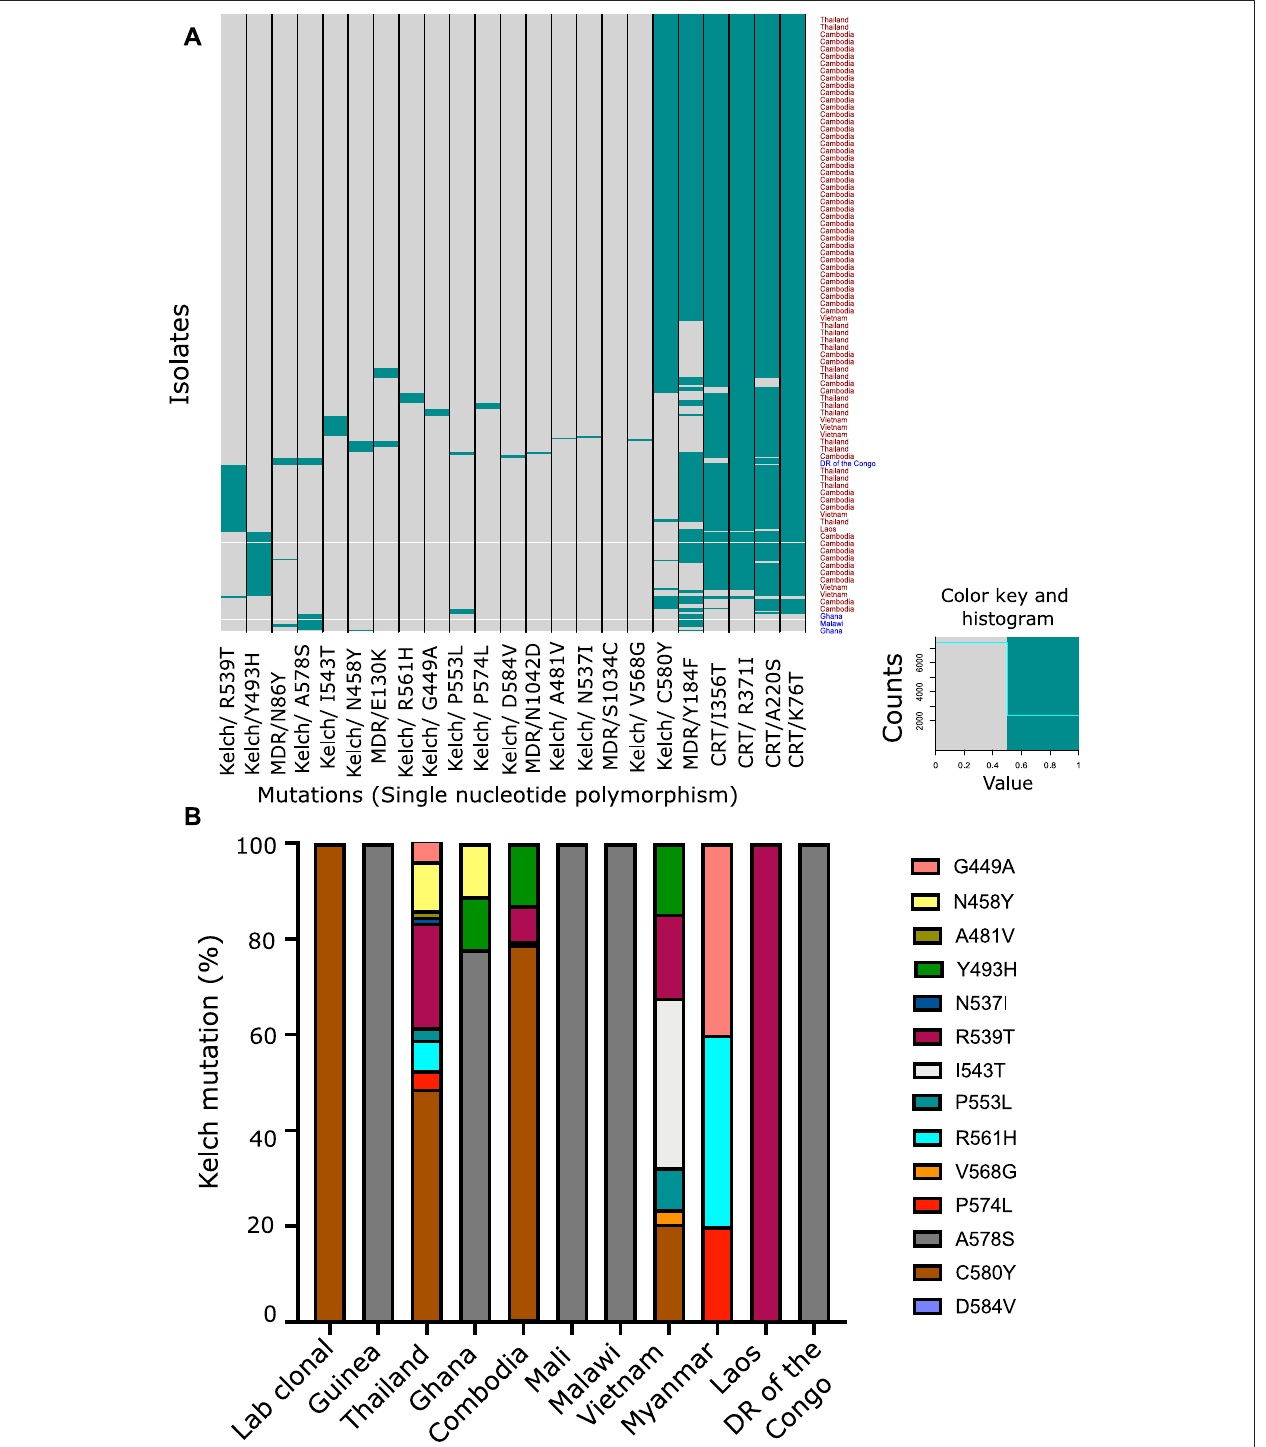
FIGURE2| Co-prevalenceofthePfKelch13mutationswithothermarkers ofmultidrugresistance. (A) SNP dataweredownloadedfromPf3K (Pilot datarelease4) MalariaGEN to analyze key mutations present in the K13 gene (PF3D7_1343700). Genomes of 2,517 isolates were available from 15 different geographical locations, majorly categorized into Africa (1,501) and Asia (1,010) subcontinents and some lab strains (6). Variant annotation for the data was done using snpEff version 4.3. Heatmap representing the mutation present in the different isolates from different geographical areas. Pfcrt (Chloroquine Resistance Transporter) and Pfmdr (Multidrug Resistance Transporter) mutations were also plotted along with the known K13 mutations to understand the co-prevalence of these mutations. (B) Fourteen of the Kelch SNPs known to be associated with artemisinin resistance were assessed for their prevalence across different geographical region and co-existence among the 424 isolates they were found in. Percentage proportion of different K13 mutation prevalent in the different countries used for the study.